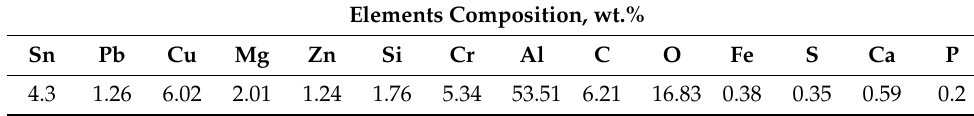
Table 11. EDS chemical identification of elements and their concentration in Al–Cr alloy worn surface. Elements Composition,